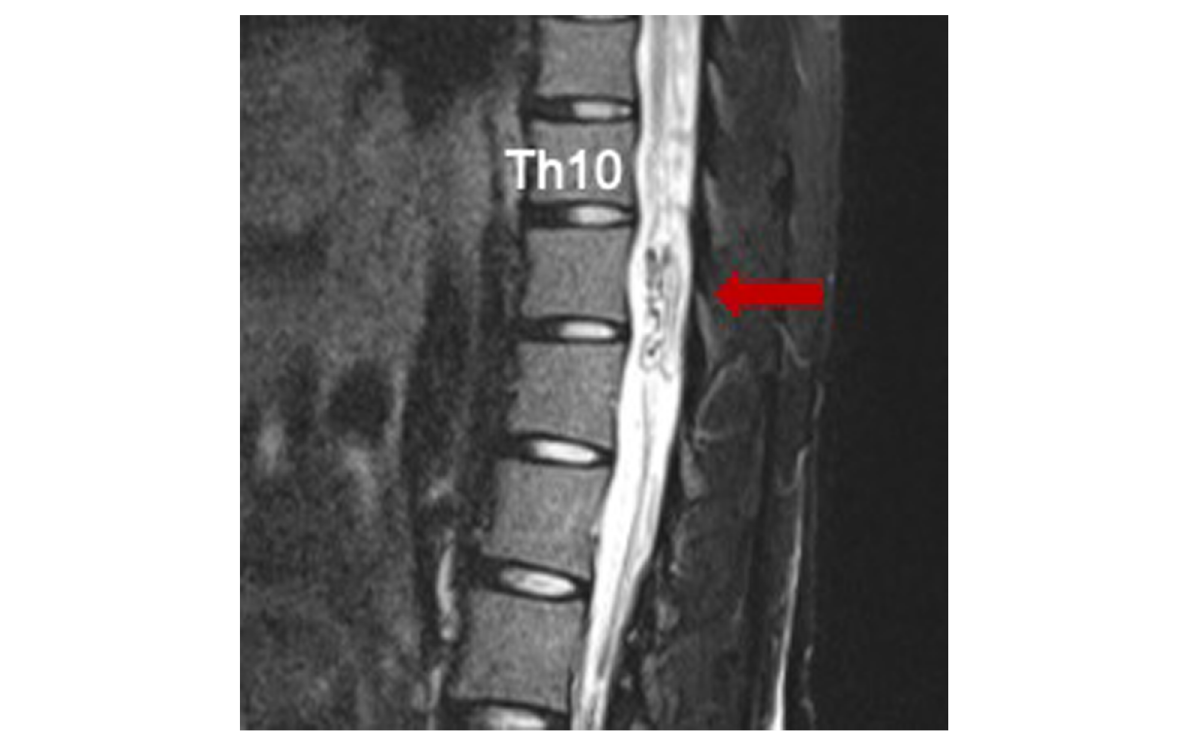
Fig. 2 Magnetic resonance imaging (T2-weighted image) in the thoracic level at 32 weeks of gestation. Flow void (the arrow) suggests a dilated draining vein. Th10, tenth thoracic